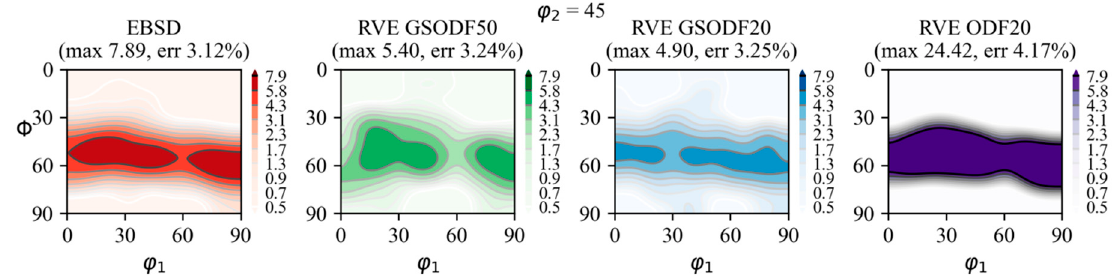
Figure 6. Orientation distribution function ( 𝜑 (cid:2870) = 45° section) calculated for the EBSD experiment and the three RVEs shown in Figure 4. The error shown on top indicates the difference between the corresponding discrete texture and the ODF calculated from the EBSD data, or between the calculated ODF and the raw data And it is calculated as the percentage of variance in intensity for all the points in a discrete grid of 5 degrees in the convenient region of Euler space (90° × 90° × 90° for cubic crystal symmetry and orthorhombic sample symmetry)